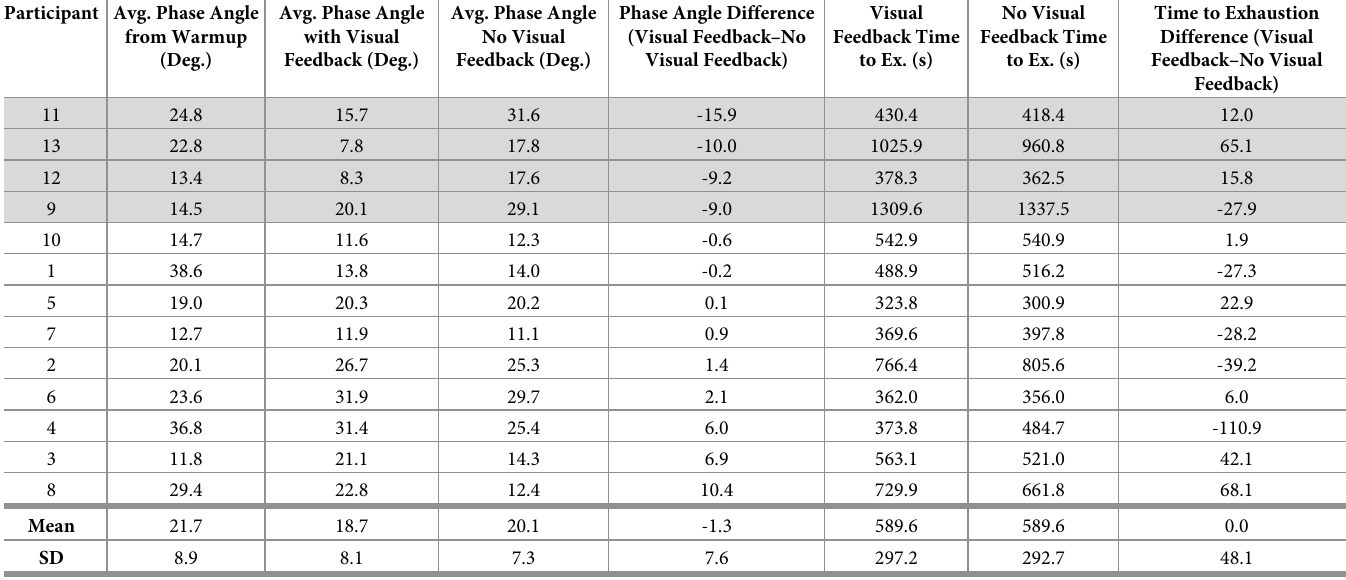
Table 2. Phase angle and time to exhaustion data for all participants. Participant Avg. Phase Angle from Warmup